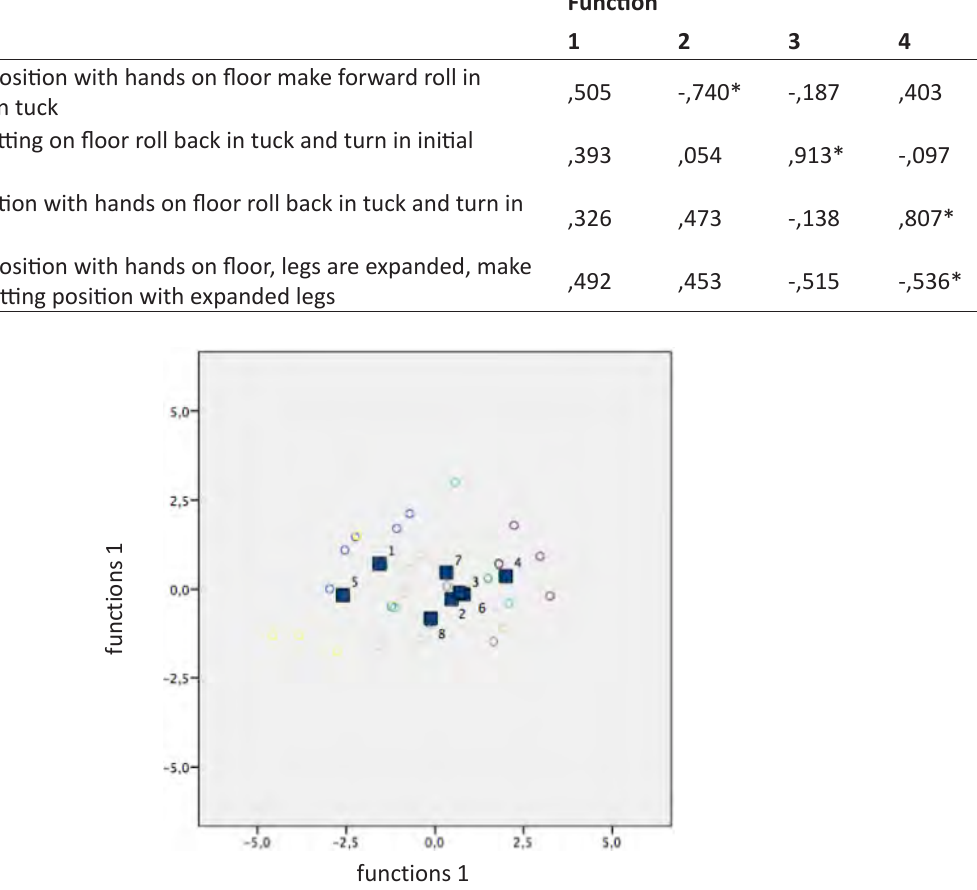
Fig. 1. Canonical discriminatory functions. Graphic representation of the results of the classification of the level of exercise execution of boys aged 8 years: ■ – centroids for data groups after 1-8 variants of exercise objects in each class and the distinct boundary between classes. This material points to the ability to choose the mode of exercise for successful training of the simmer